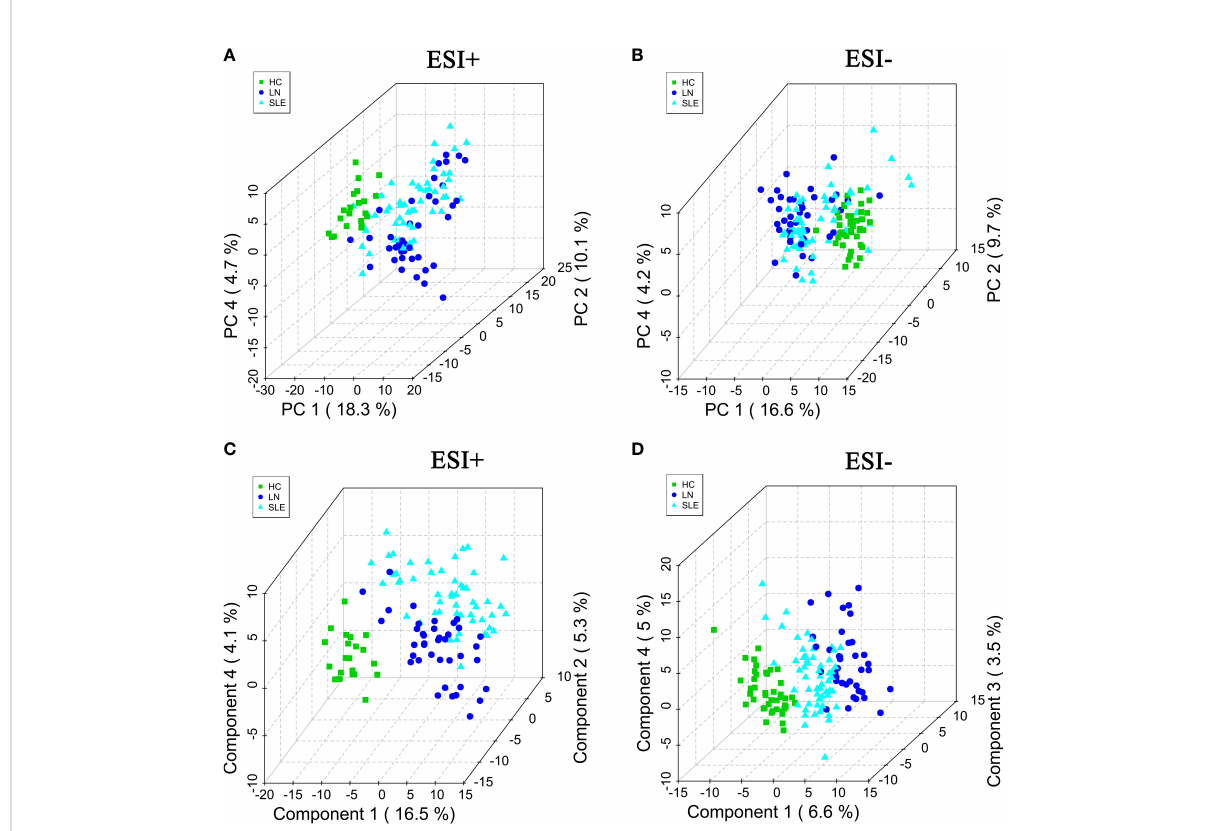
FIGURE 1 The PCA score plots in positive (A) and negative (B) ion modes among HC, SLE and LN groups. The PLS-DA score plots in positive (C) and negative (D) ion modes among HC, SLE and LN groups. PCA, principal component analysis; PLS-DA, partial least squares discriminant analysis; HC, healthy controls; SLE, Systemic lupus erythematosus; LN, Lupus